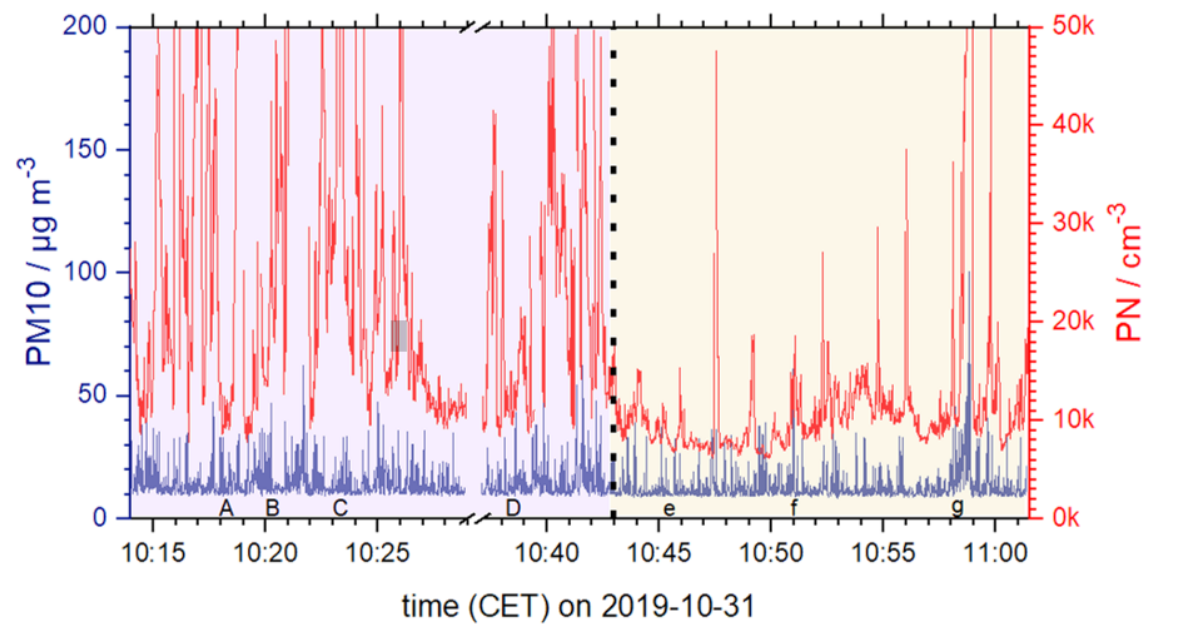
Figure 4. Concentrations of PN (red; right axis) and PM10 (blue; left axis) of ride 3 on 31 October 2019, when the bicycle rode along the high-traffic route first (until 10:43 CET) and then along the low-traffic route. Same data as those shown in Figure 3. Points of interest and orientation are as in Figure 3 (capital letters for the high-traffic route, darker background; lowercase letters for low-traffic route, light background). The x-axis break represents a pause of measurement due to intermittent instrument malfunction (while the bicycle stopped).